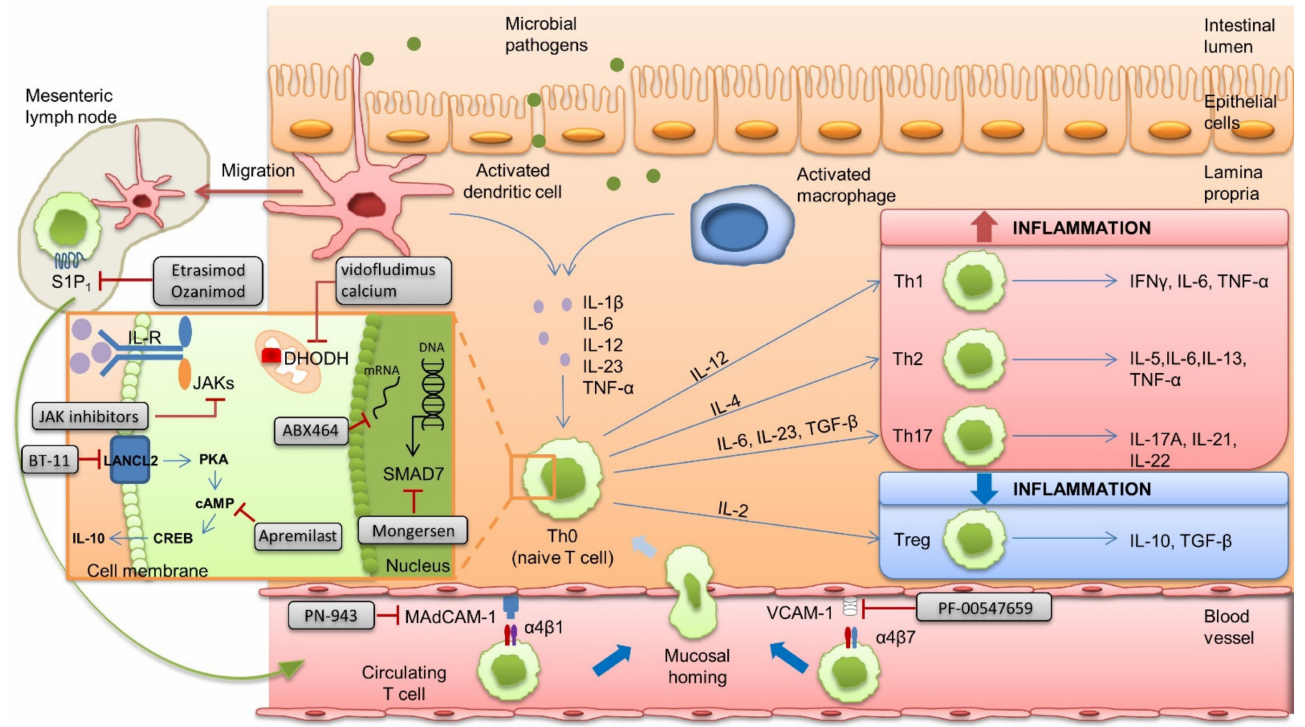
Figure 1. Presentation of the intestinal immune system in patients with inflammatory bowel disease and potential therapeutic targets for Small Molecule Drugs (SMDs). Intestinal immunity under normal conditions is regulated by both antigen-presenting cells (dendritic cells (DCs)) and macrophages in immediate proximity to DCs. Upon antigen recognition, activated macrophages and DCs produce proinflammatory cytokines that consequently promote the transformation of